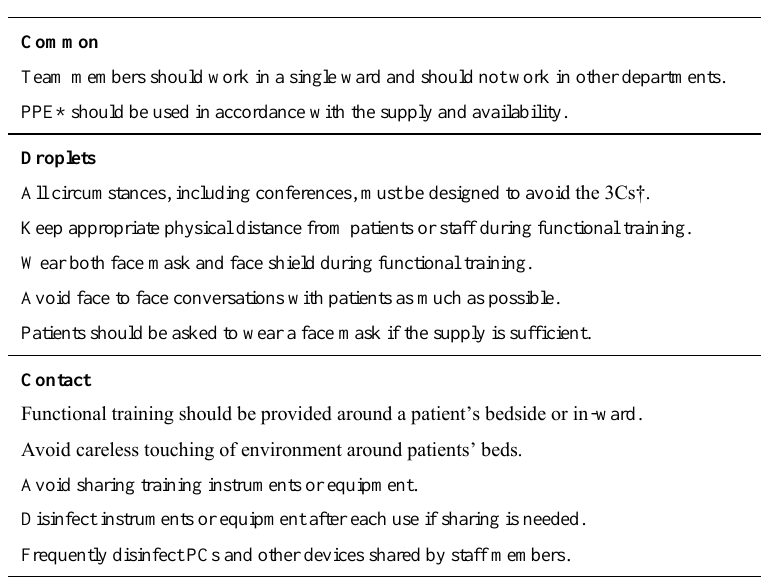
Table 1. Infection control measures for the rehabilitation team